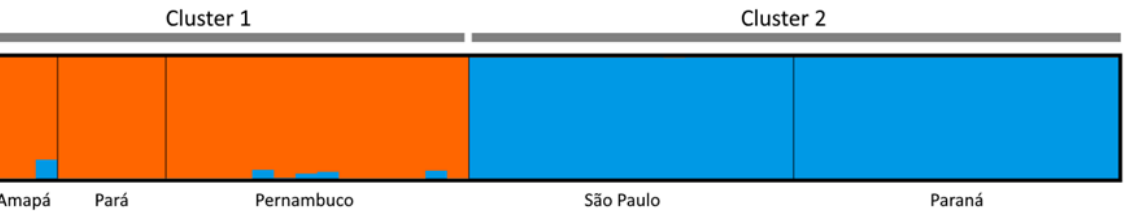
S ã o Paulo and Paran á was observed (Figure 2).